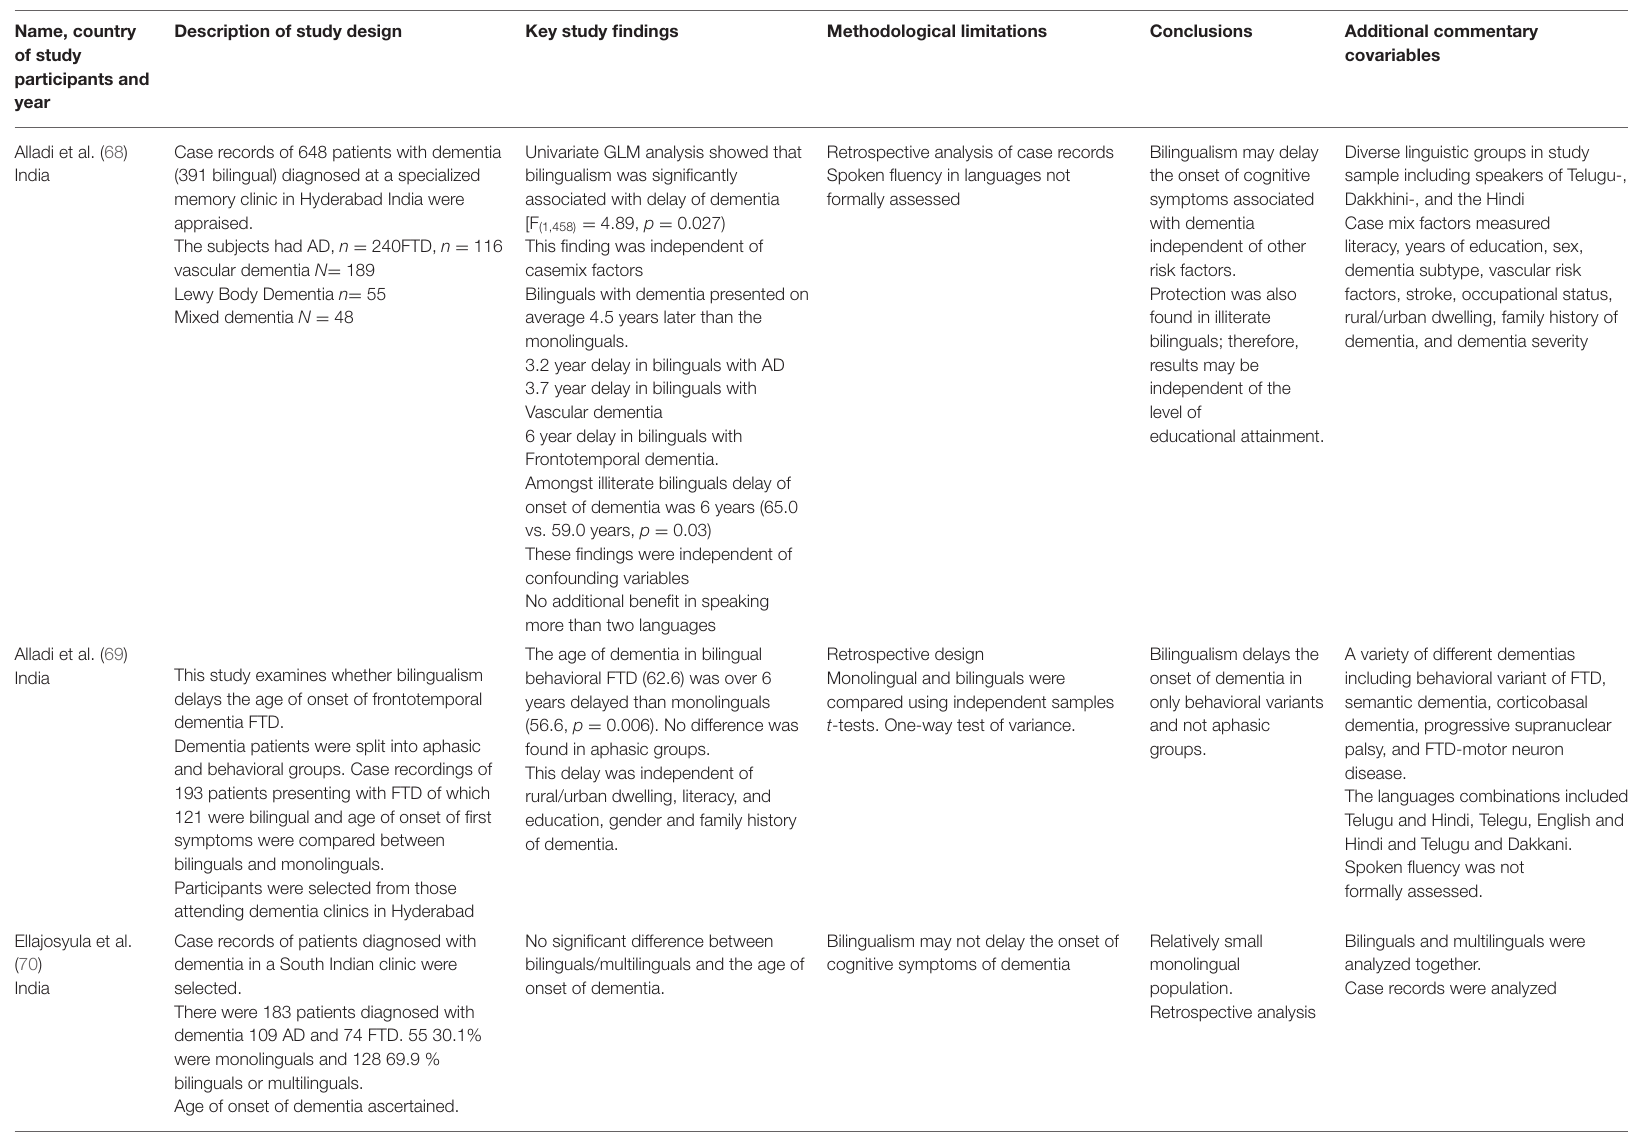
TABLE 2 | Studies of Bilingualism and age of onset of dementia in